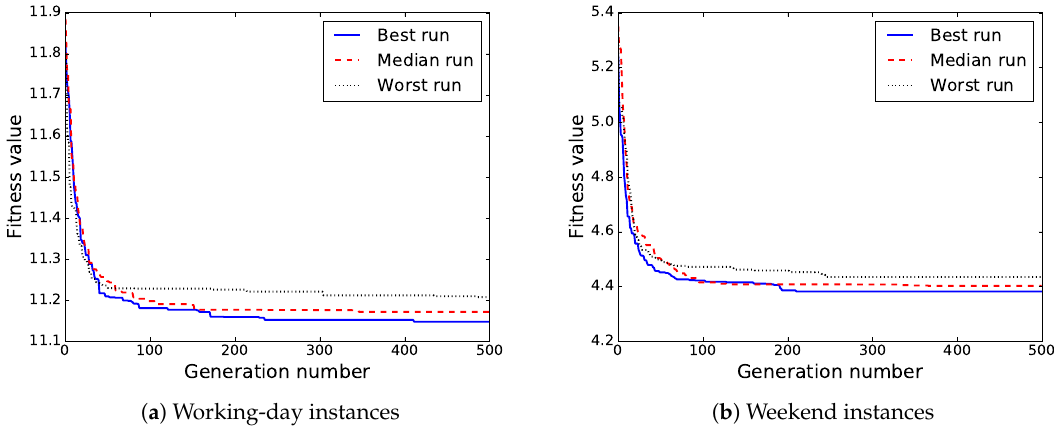
Figure 11. Fitness evolution through the best, median, and worst independent run.